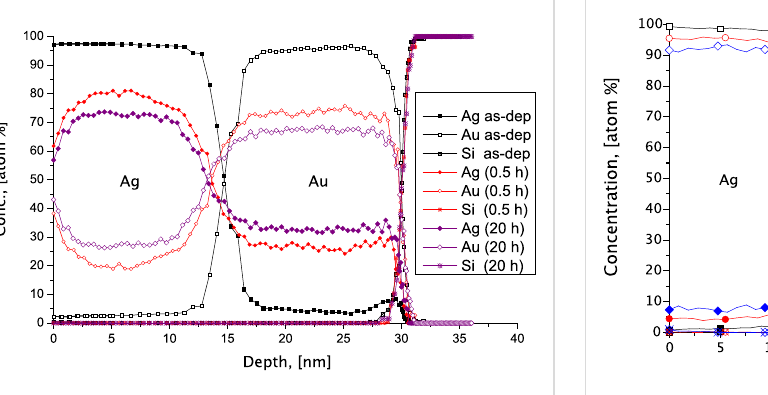
Figure 1: Concentration–depth profile in Ag(15 nm)/Au(15 nm) bilayer; as deposited and annealed at 170 °C.